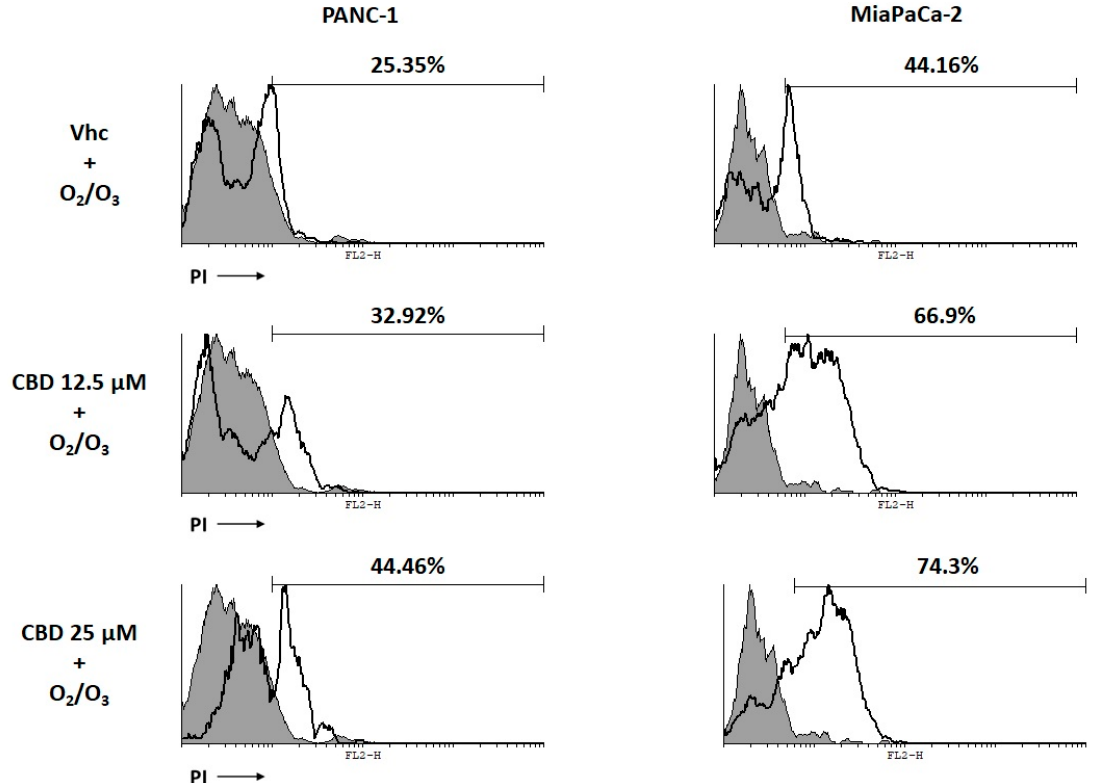
Figure 8. O 2 /O 3 induced necrotic cell death in PDAC cell lines. PDAC cell lines were treated with O 2 /O 3 and CBD for 24 h. Flow cytometric analysis was performed by Annexin V/PI staining. Data represent the percentage of PI positive cells and are representative of one of three separate experiments.